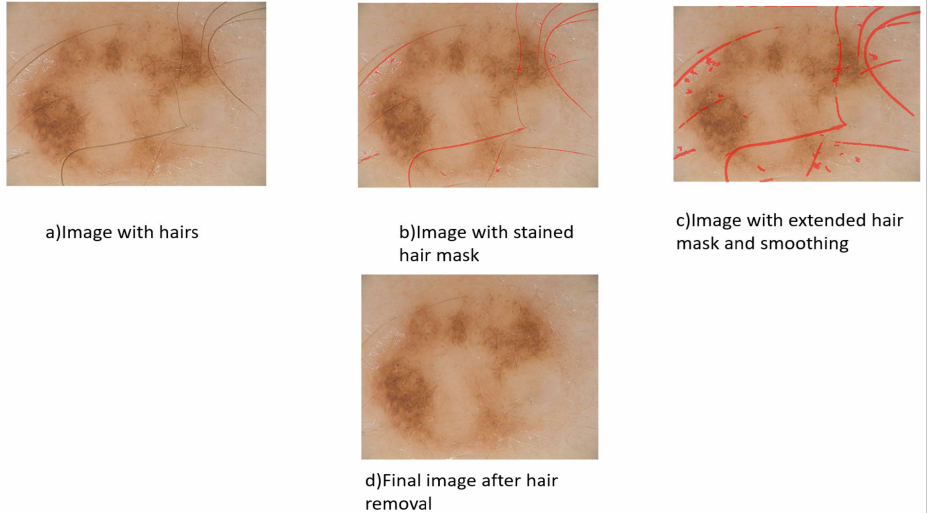
Figure 3. Stages of hair removal of images after applying the DullRazor